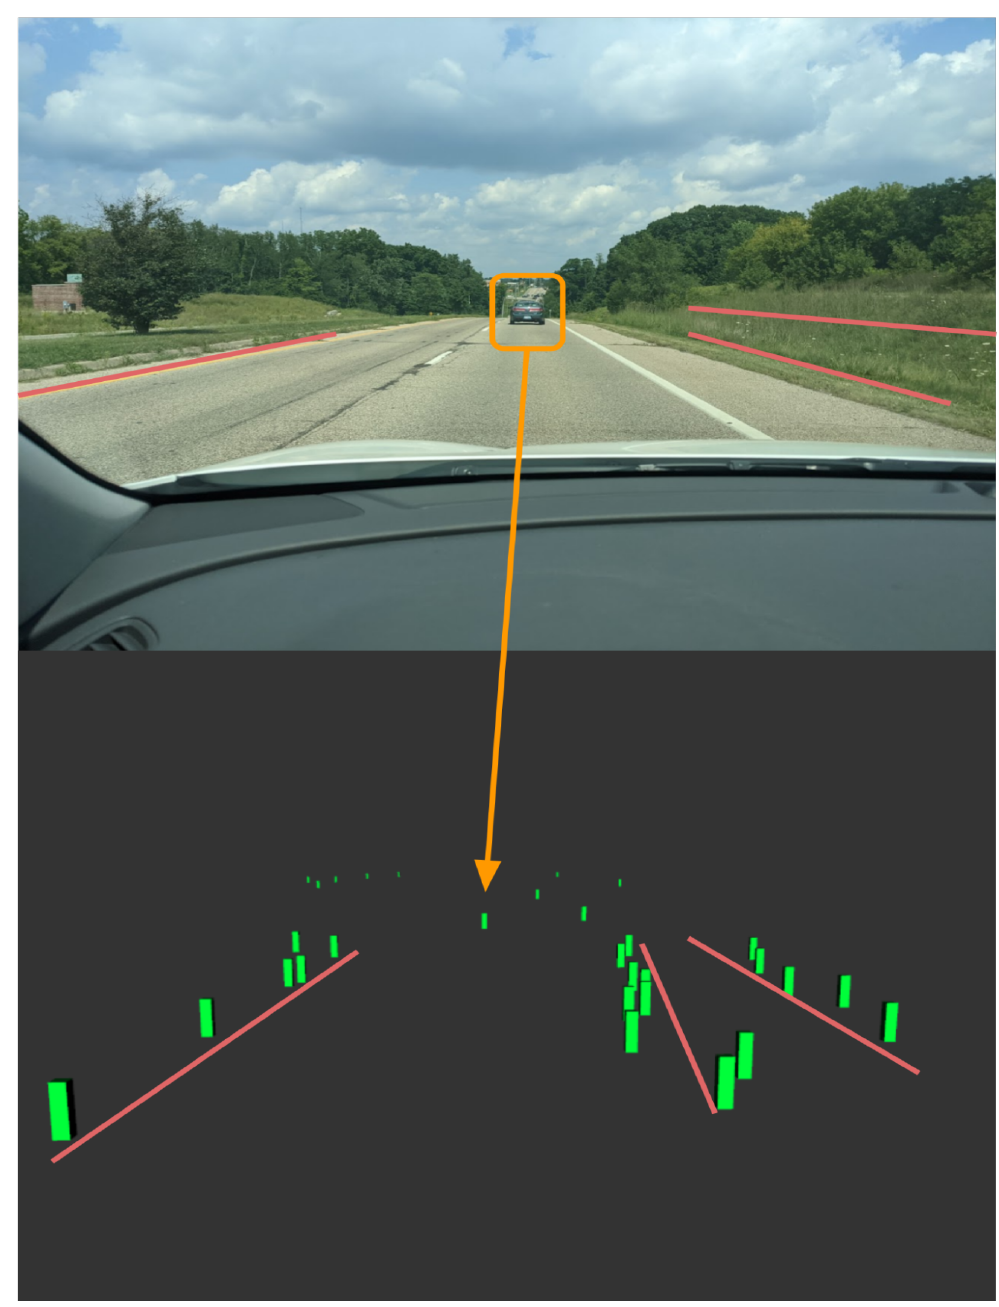
Figure 18. Aptiv ESR object marker visualization using Rviz with ROS. The red lines show the curb to the left and the high grass just before the berm, which is all detected by the